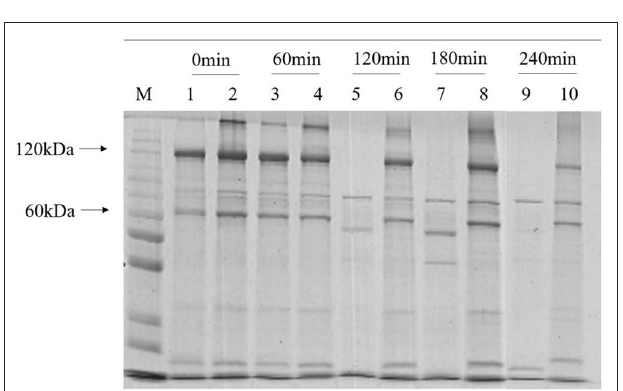
FIGURE 6 | SDS-PAGE of insecticidal proteins of strain HD-1 and HD-1- 1 hmgA after UV irradiation. The marker is 200, 150, 120, 100, 85, 70, 60, 50, 40, 30, and 25 kD from top to bottom. Lanes 1, 3, 5, 7, and 9 are wild-type HD-1 under UV treatment for 0, 60, 120, 180, 240min; lanes 2, 4, 6, 8, and 10 are mutant HD-1- 1 hmgA under UV treatment for 0, 60, 120, 180, and 240min. The arrow marks from top to bottom are several typical Cry proteins.